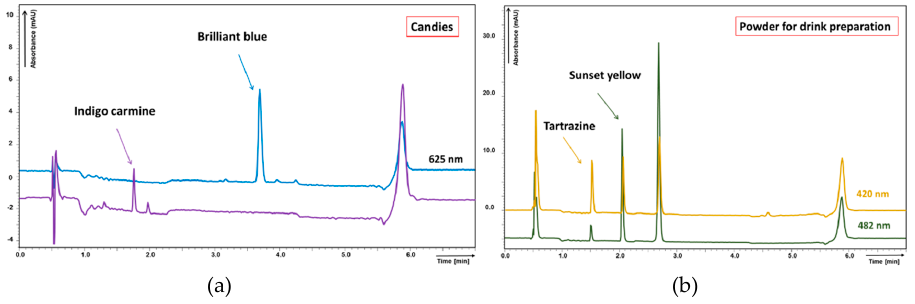
Figure 3. Chromatograms of sample matrices (analysed by method II): ( a ) candies and ( b ) powder for drink preparation. Found colorants in concentration: ( a ) indigo carmine 0.62 mg L − 1 , brilliant blue 1.29